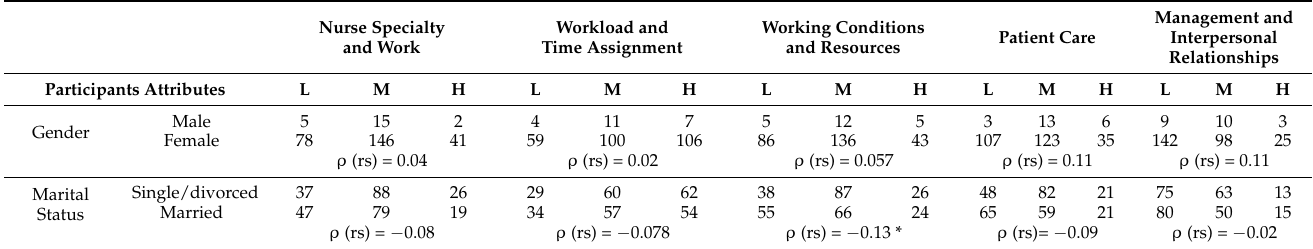
Table 4. Correlation coefficients between participants’ attributes and the level of stress in each of the five